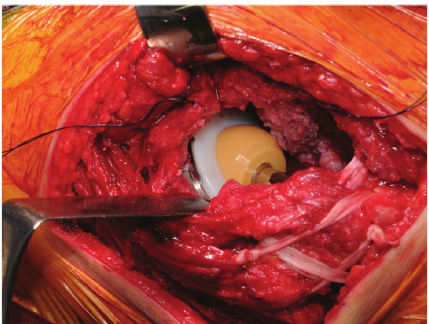
Figure 6: Photograph of the implant in place. We stabilized the fractured greater trochanter with tension band wiring using Kirschner wire and nylon tape.